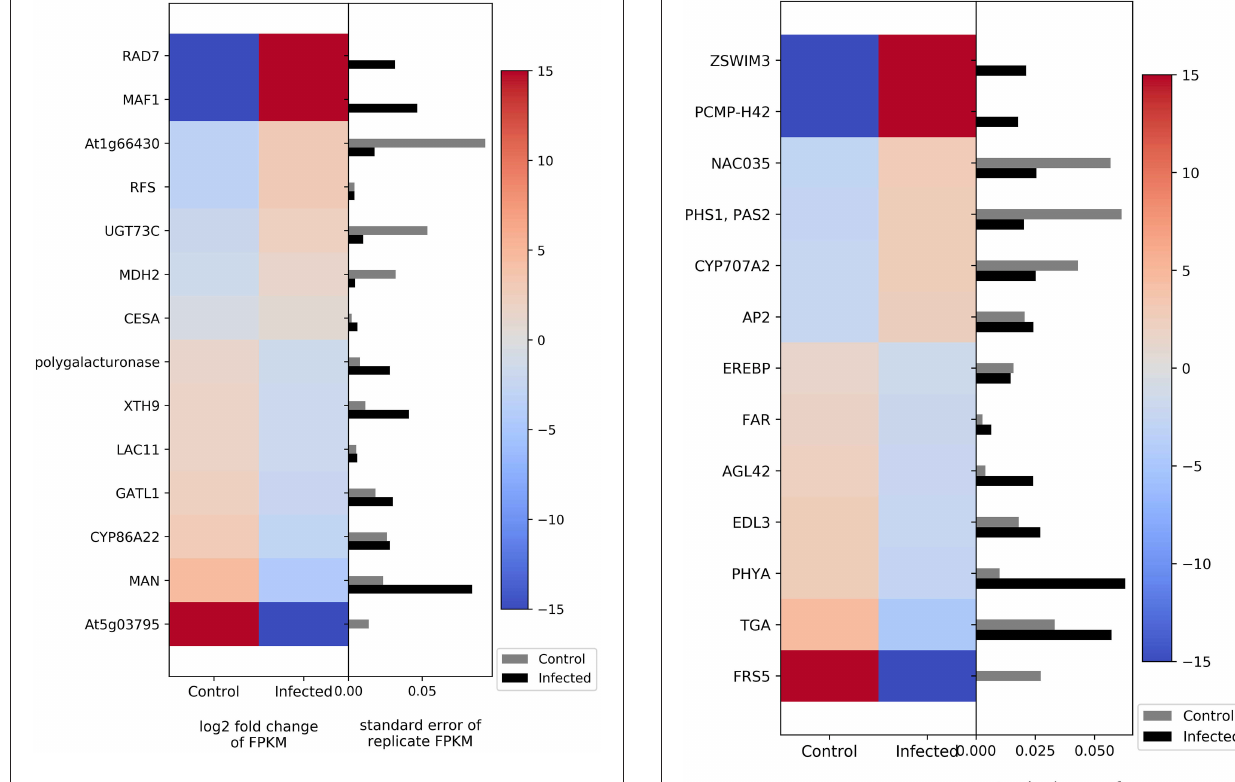
FIGURE 4 | Heatmap of DEGs related to photosynthesis and carbohydrate metabolism. The left side of the plot is the heatmap of log2 fold change of FPKM between all infected and uninfected groups. The right side of the plot is the standard error for all replicates divided by the average FPKM for the uninfected and infected groups. See Supplemental Table 2 for gene names associated with all abbreviations.